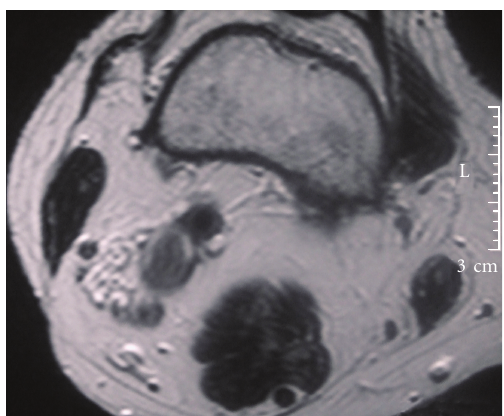
Figure 4: MR scan shows the small Saphenous vein aneurysm.